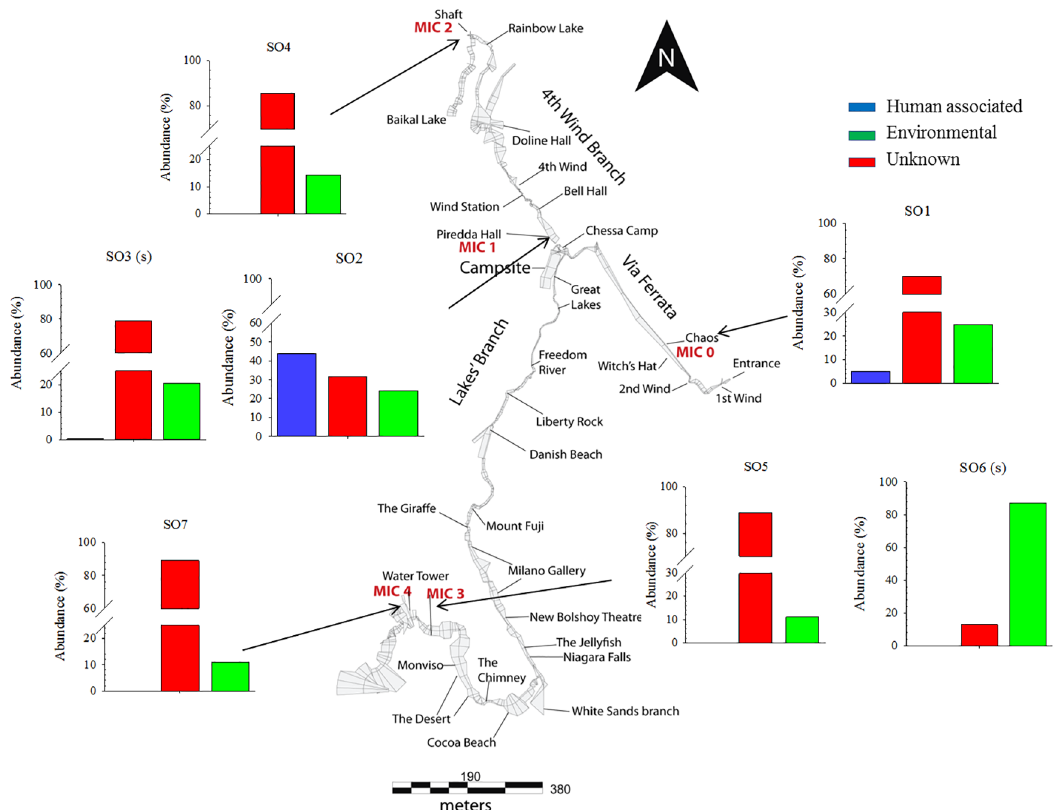
Fig 6. Impact of human exploration on the microbial diversity in a hypogean system. The most abundanthuman associated genera(as previouslydescribedby The Human Microbiome Project Consortium)were used for this analysis and include Lactobacillus , Propionibacterium , Streptococcus , Bacteroides , Corynebacterium , Staphylococcus , Moraxella , Haemophilus , Prevotella ,and Veillonella